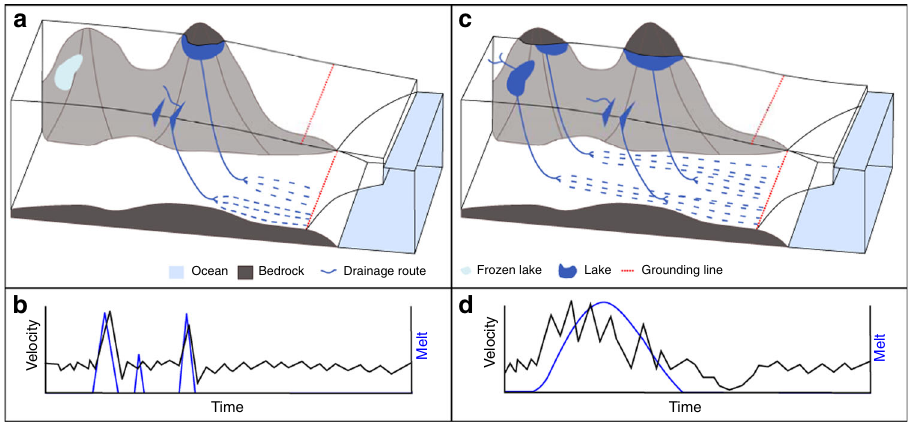
Fig. 6 Schematic of potential shift in seasonal Antarctic glacier dynamics. a Current situation in Antarctic Peninsula. b Dynamics of Antarctic peninsula and High Arctic melt-induced speed-ups. c Greenlandic, and potential future Antarctic drainage systems. d Ice melt and speed response to scenario shown in